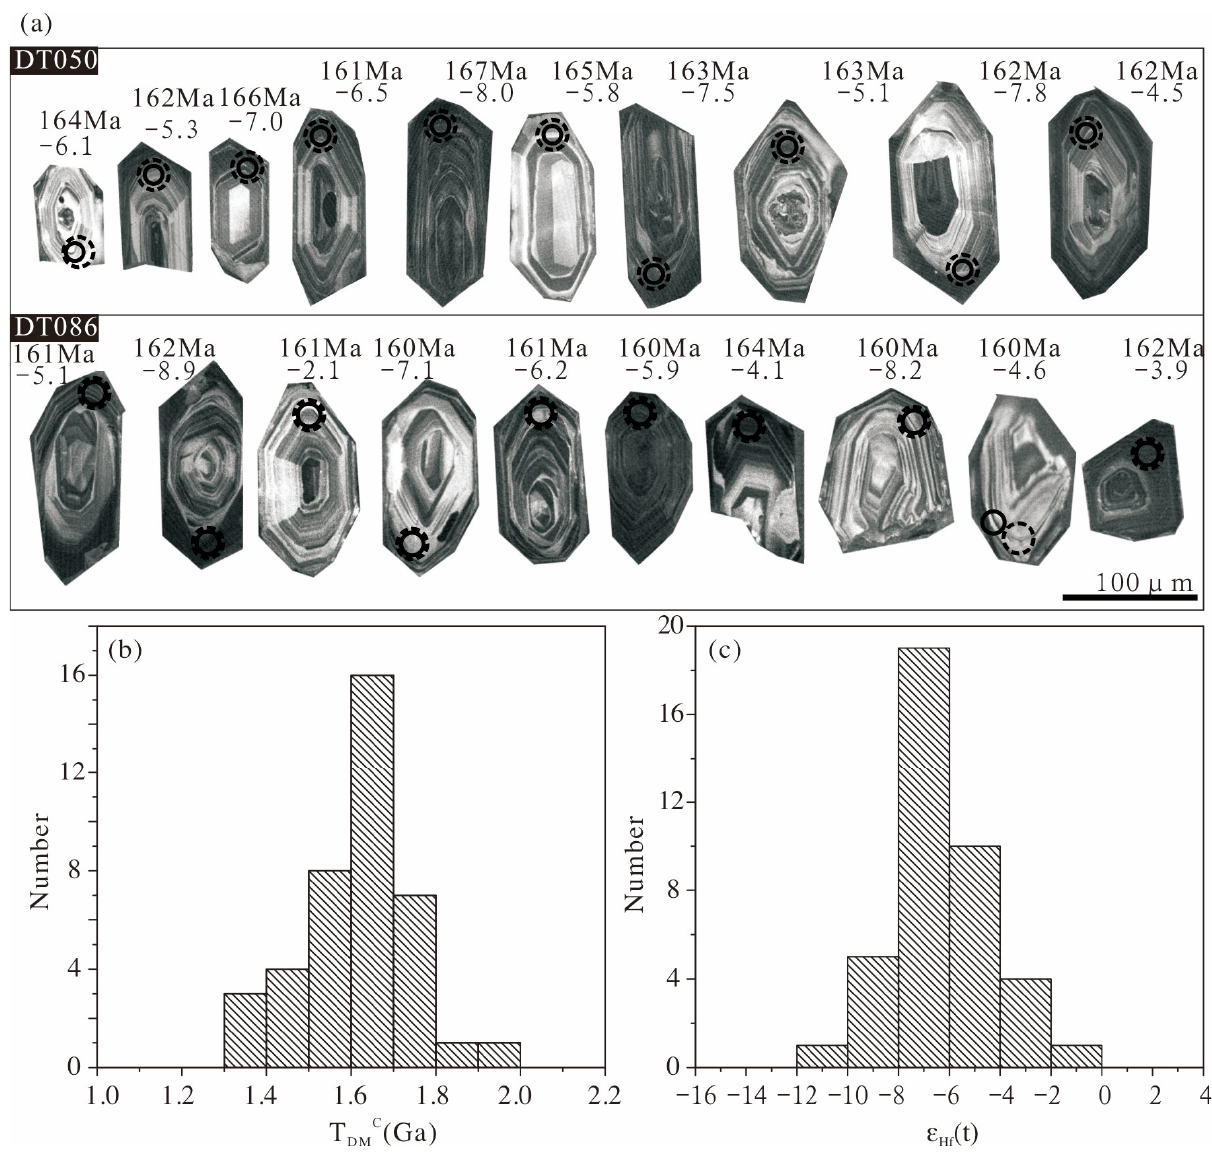
Figure 6. ( a ) CL images of zircons from Dongxiang granodiorite porphyries (DT050 and DT086) [12]. Smaller circles indicate the spots of U-Pb dating, using data from Cai et al., 2017, whereas the bigger dashed circles indicate the spots of Hf isotopes analyses. Ages and ε Hf (t) values are shown for each spot (age data are from Cai et al., 2017) [12]. ( b ) Histogram of two-stage model ages (T DM C ) for zircons from the Dongxiang intrusive rocks. ( c ) Histogram of ε Hf (t) values for zircons from the Dongxiang intrusive rocks.